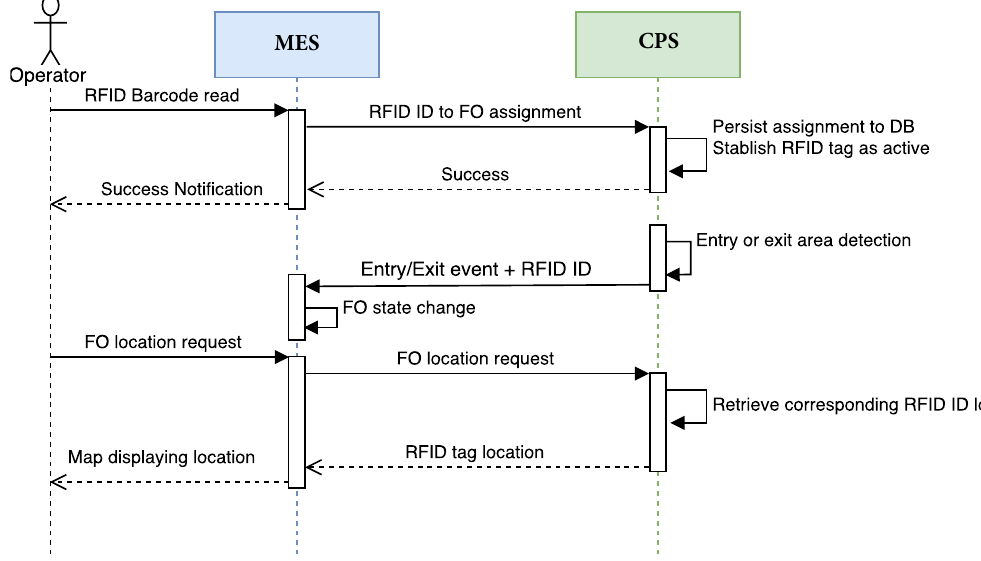
Figure 16. Sequence diagram of the interaction between CPS and